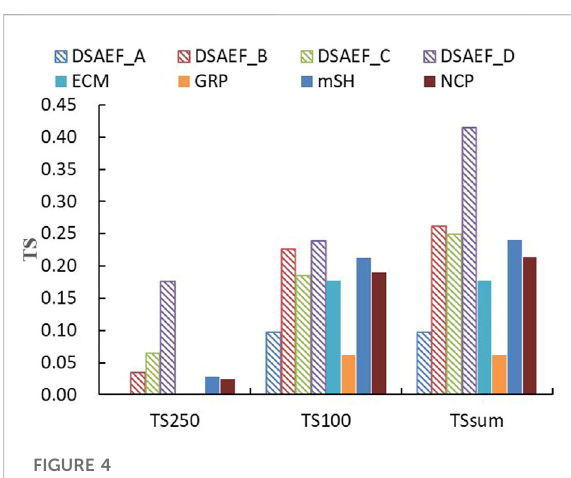
FIGURE 4 Comparison of the TS of the DSAEF_LTP model with